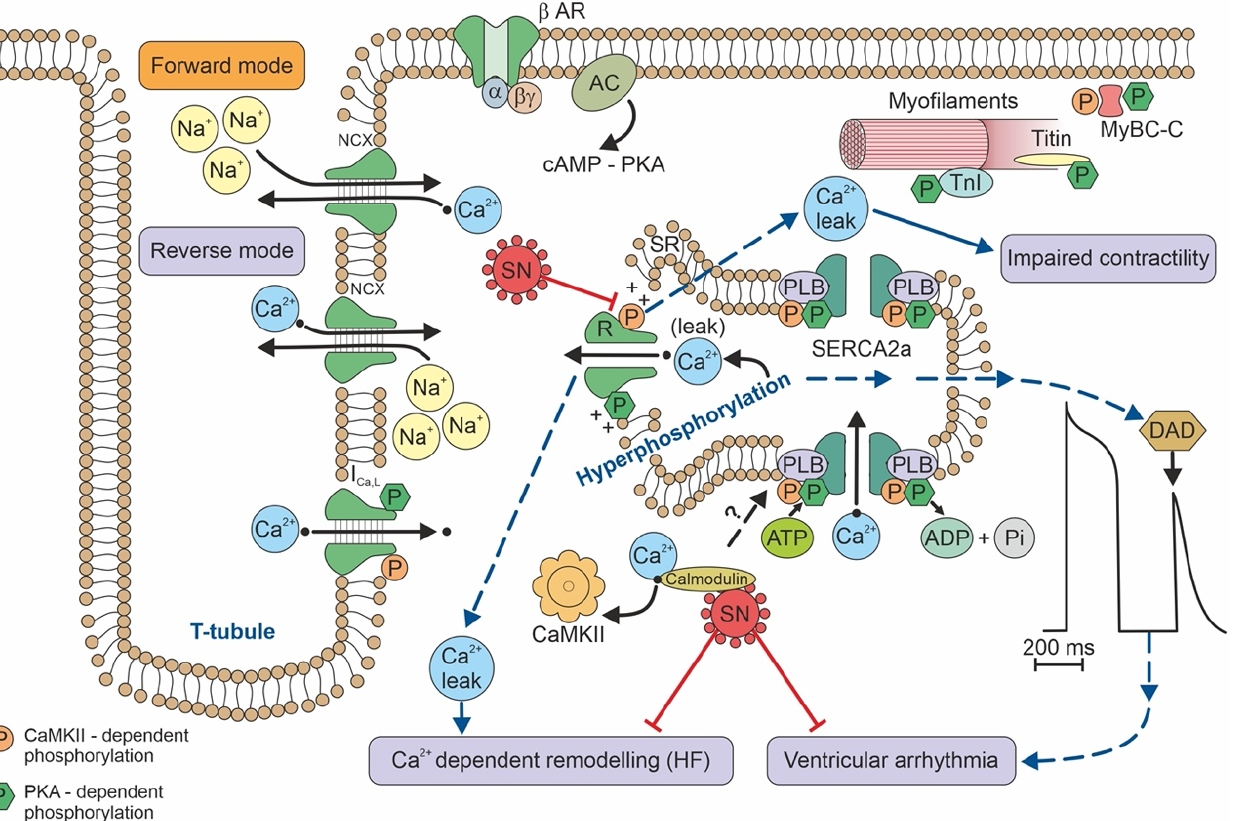
Figure 2. Calcium handling/signaling in a ventricular cardiomyocyte illustrates the potential involvement of SN in arrhythmogenic risk, heart failure, and calcium-dependent remodeling. AC — adenylyl cyclase; ADP — adenosine diphosphate; ATP - adenosine triphosphate; β -AR — beta adrenergic receptor; cAMP — cyclic adenosine monophosphate; CaMKII — calmodulin-dependent kinase II; DAD — delayed afterdepolarizations in the electrocardiogram; HF — heart failure; I Ca,L — calcium L-type channel current; MyBP-C — myosin binding protein C1; NCX — sodium-calcium exchanger; P — phosphorus; PKA — protein kinase A; PLB — phospholamban; R — ryanodine receptor; SERCA2a — the sarcoplasmic/endoplasmic reticulum Ca 2+ ATPase 2a; SN — secretoneurin; SR — sarcoplasmic reticulum; TnI — troponin I.